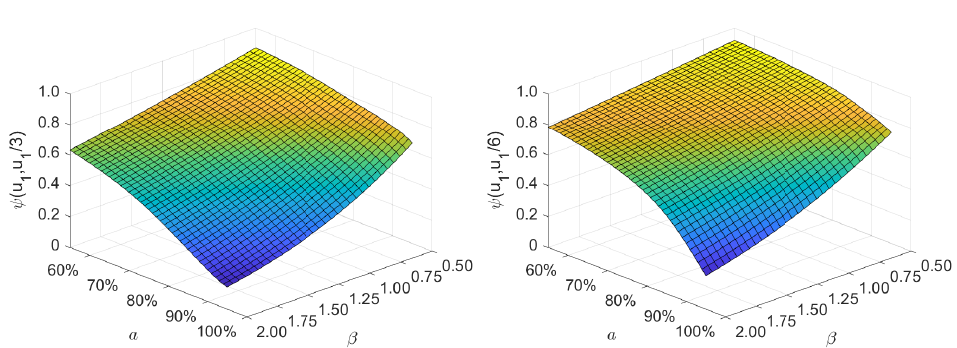
Figure 2. A comparison of the joint ruin probability values obtained with the use of Theorem 1 (Method 1) for various values of the β parameter of the exponential claim amount random variable, β ∈ ( 0.5,2 ) , and for various values of the a parameter of the quota-share contract proportion, a ∈ ( 55%,95% ) . Common parameters are u 1 = 10, θ 1 = 10%, θ 2 = 3%, and λ = 10. Note that in the left panel, the initial capital of the reinsurer is u 2 = u 1 /3, while in the right panel, it is u 2 = u 1